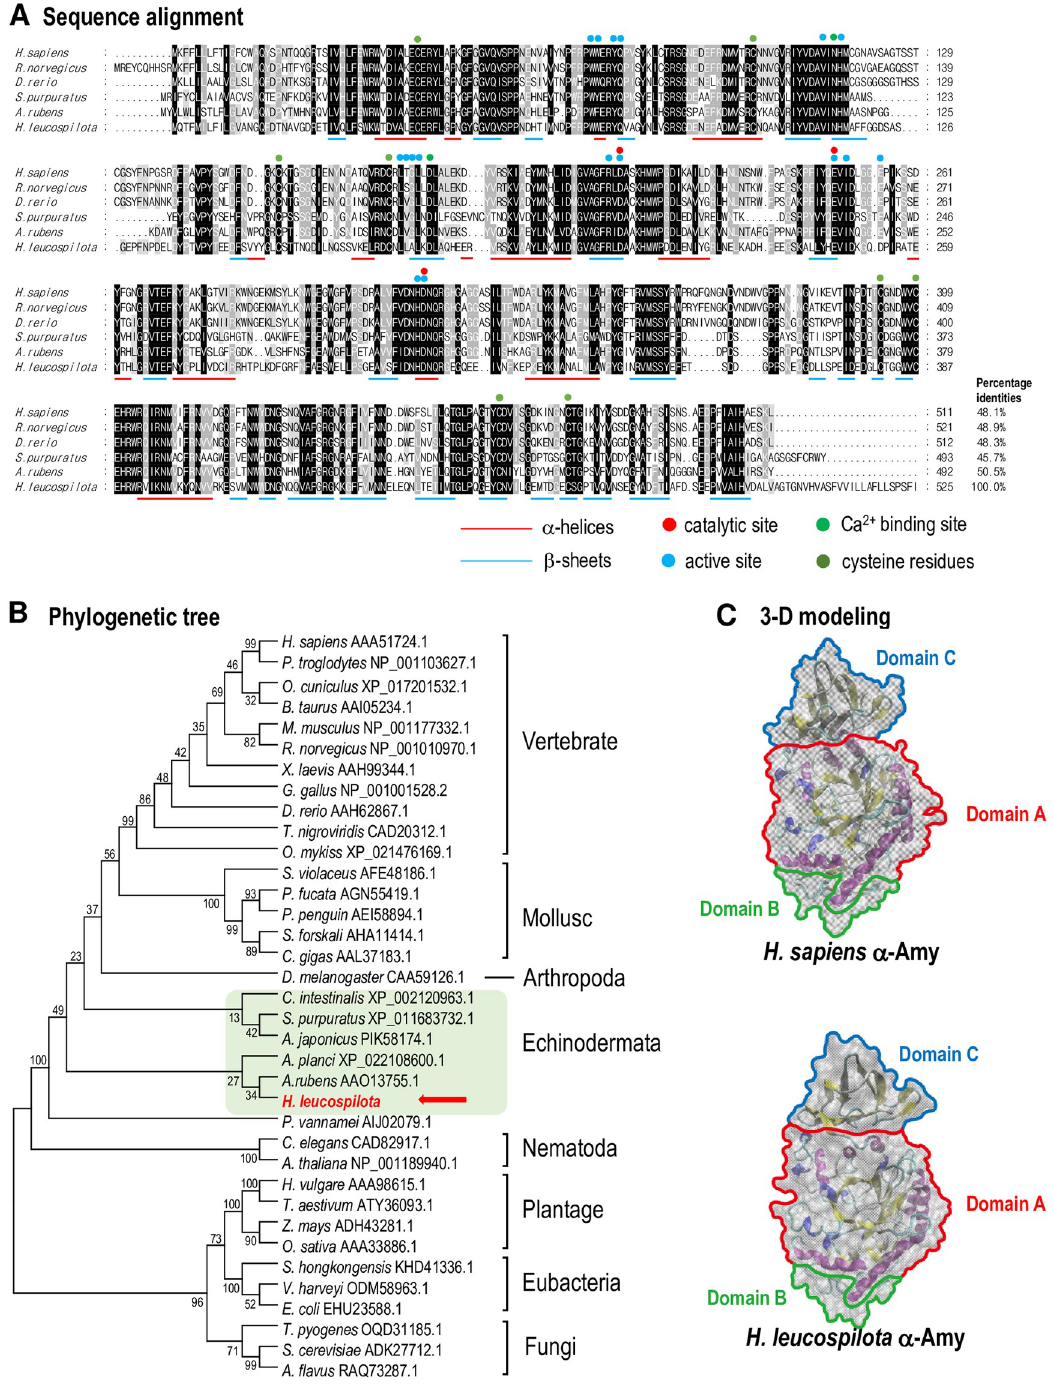
Fig 2. Amino acid sequence alignment, phylogenetic and 3D structure analysis of Hl-Amy. A : Amino acid sequence alignment of Hl-Amy and amylase in other deuterostome animal species. The conserved amino acid residues are boxed in dark gray and similar amino acid residues are labeled in light gray. The α -helices, β -sheets are underlined the conserved cysteine residues are indicated, and the active site, Ca 2+ binding site and catalytic site are shown. B : Phylogenetic analysis of amylase in various species using the Neighbor-Joining method with a bootstrap value of 1000. The amylases of echinoderms are boxed, and our newly identified Hl-Amy is shown with a red arrow. C : Comparison of the 3D structures models for human ( H . sapiens ) and sea cucumber ( H . leucospilota ) amylases. The structural domain A, B and C are indicated.